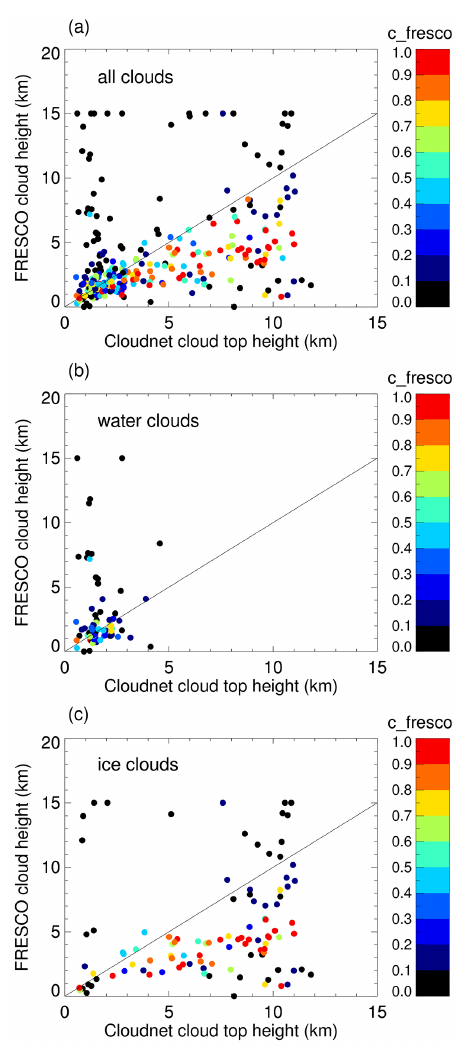
Figure 5. Scatter plots of SCIAMACHY FRESCO cloud height vs. Cloudnet cloud top height, for (a) all single-layer clouds, (b) single- layer water clouds, and (c) single-layer ice clouds. The color of the symbol indicates the FRESCO effective cloud fraction, with the color code given by the vertical bar. The black line is the one-to-one line. For the points with c_fresco > 0.1, the correlation coefficients are (a) 0.685, (b) 0.206, and (c)